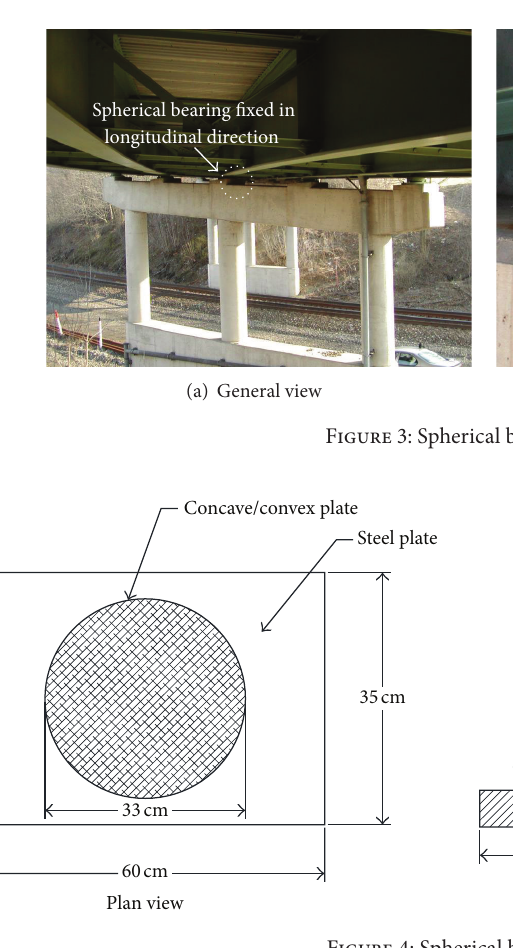
Figure 4: Spherical bearing details.